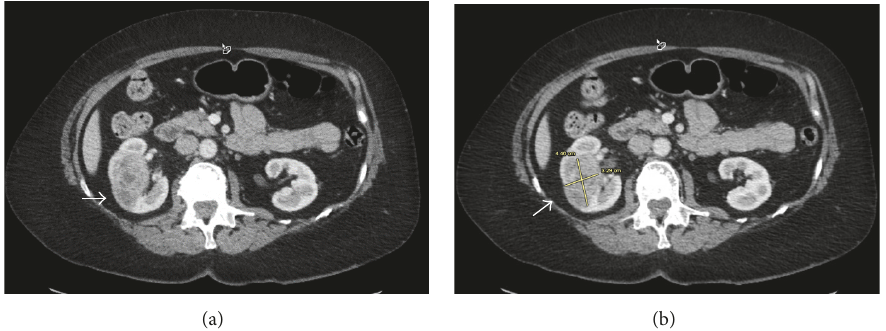
Figure 1: Computed tomogram of the abdomen-pelvis with contrast shows a 4.5 × 3.3 cm heterogeneous, enhancing soft-tissue density mass within the right kidney with a patent right renal vein (white